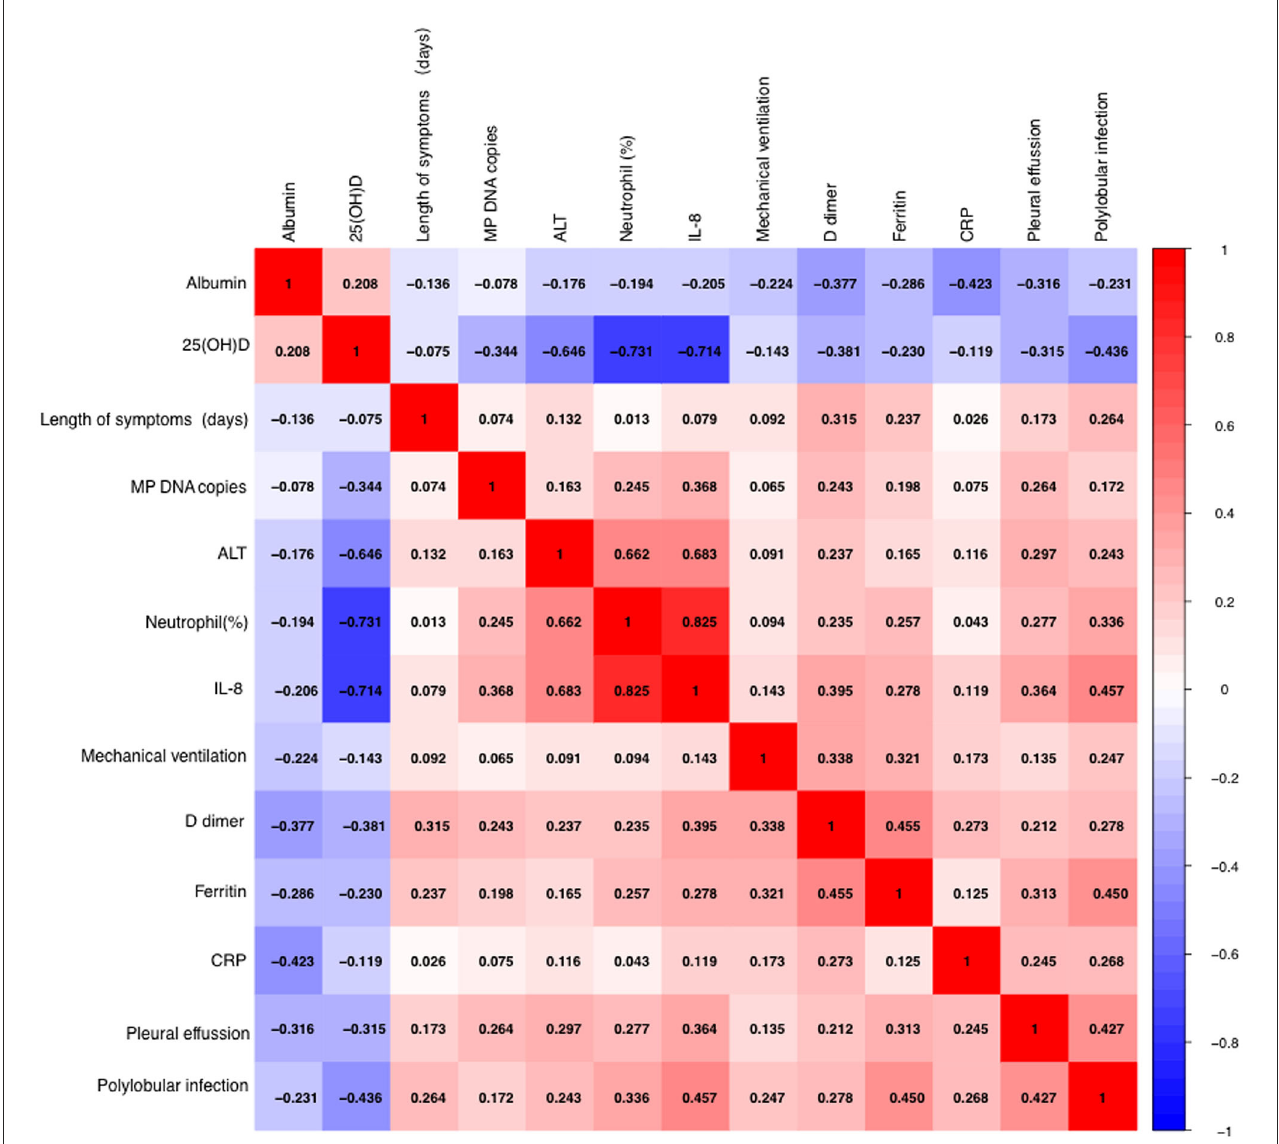
FIGURE3 Spearman’s and Pearson’s correlational analyses of hematological and biochemical parameters. The correlation analysis matrix shows correlations between each of the 13 parameters. The color scale bar denotes correlation strength, with 1 indicating a positive correlation and − 1 indicating a negative